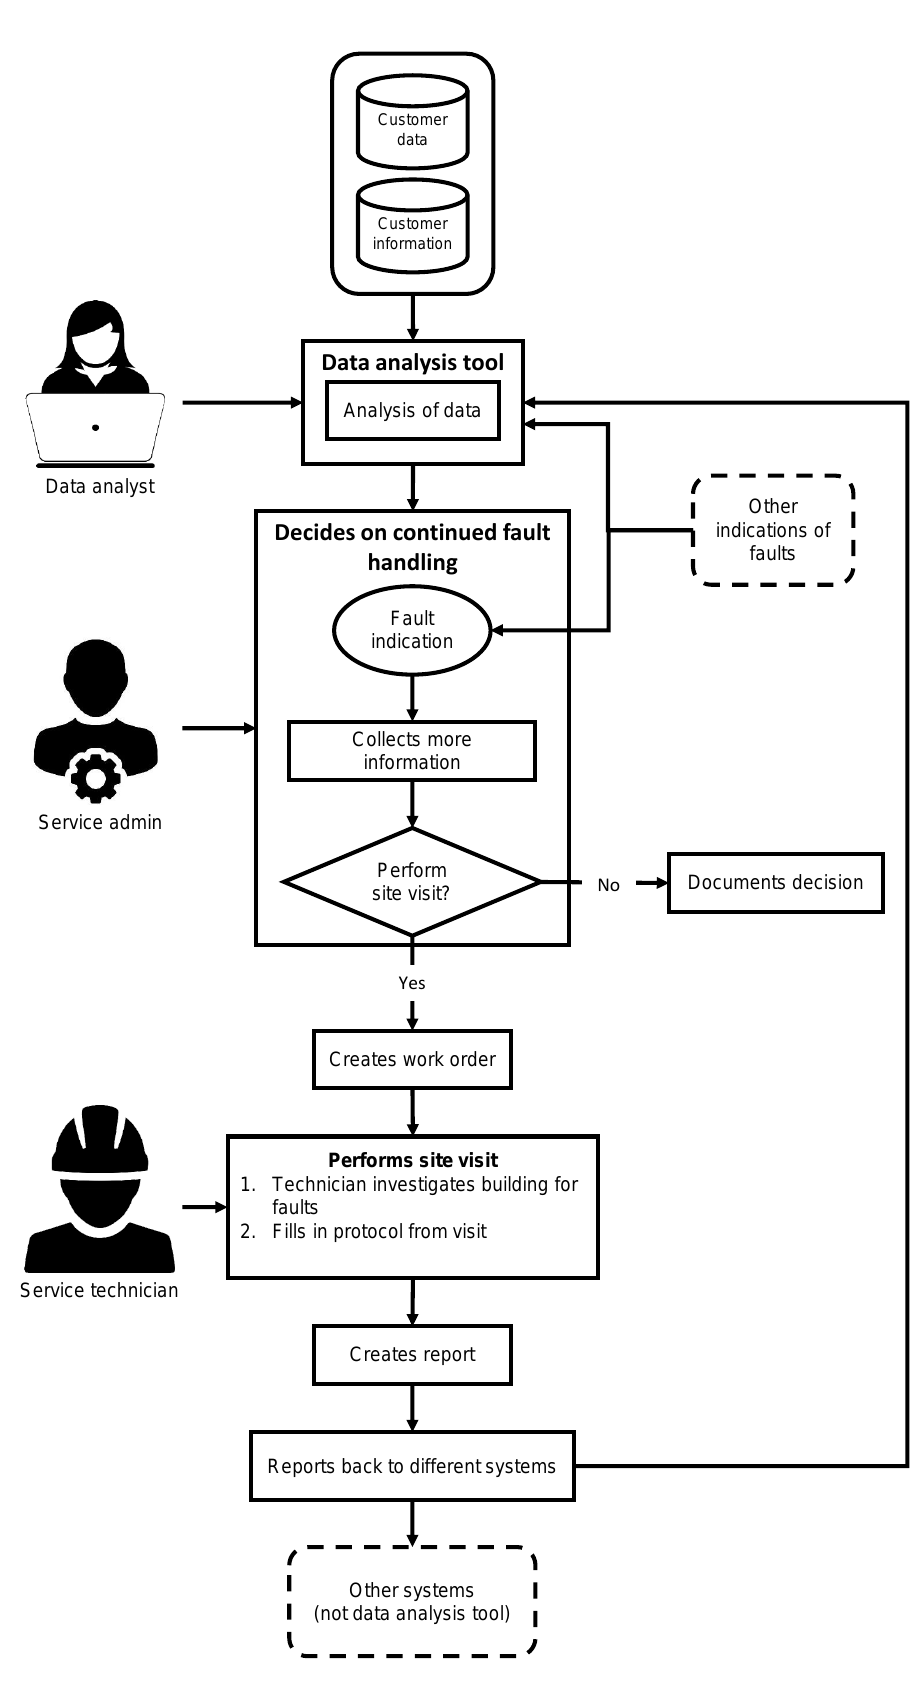
Figure 1. Suggested work flow for fault handling of district heating customer installations using analysis of customer